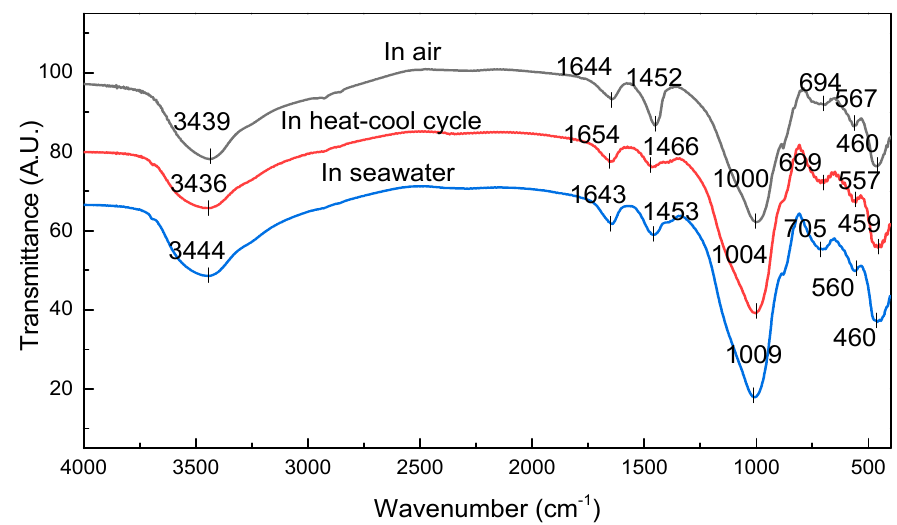
Figure 5. FTIR spectra of the geopolymers prepared with 60% metakaolin and different exposures.